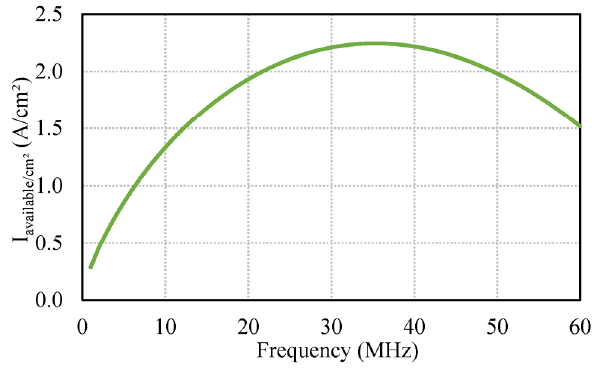
Figure 5. Available current per cm 2 under 20 V depending on the operating frequency for LNO.